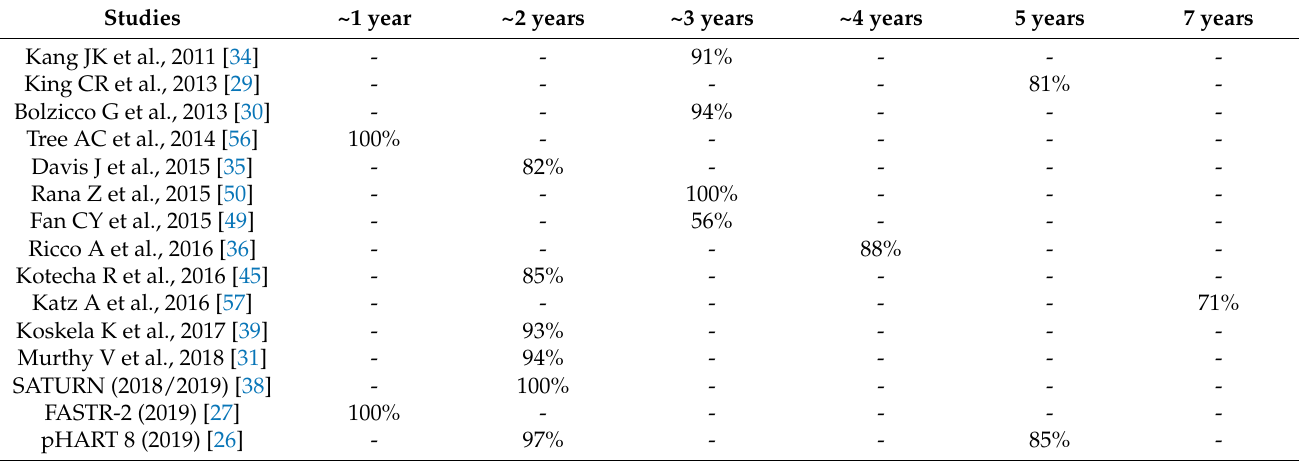
Table 3. Biochemical control rates reported in the individual